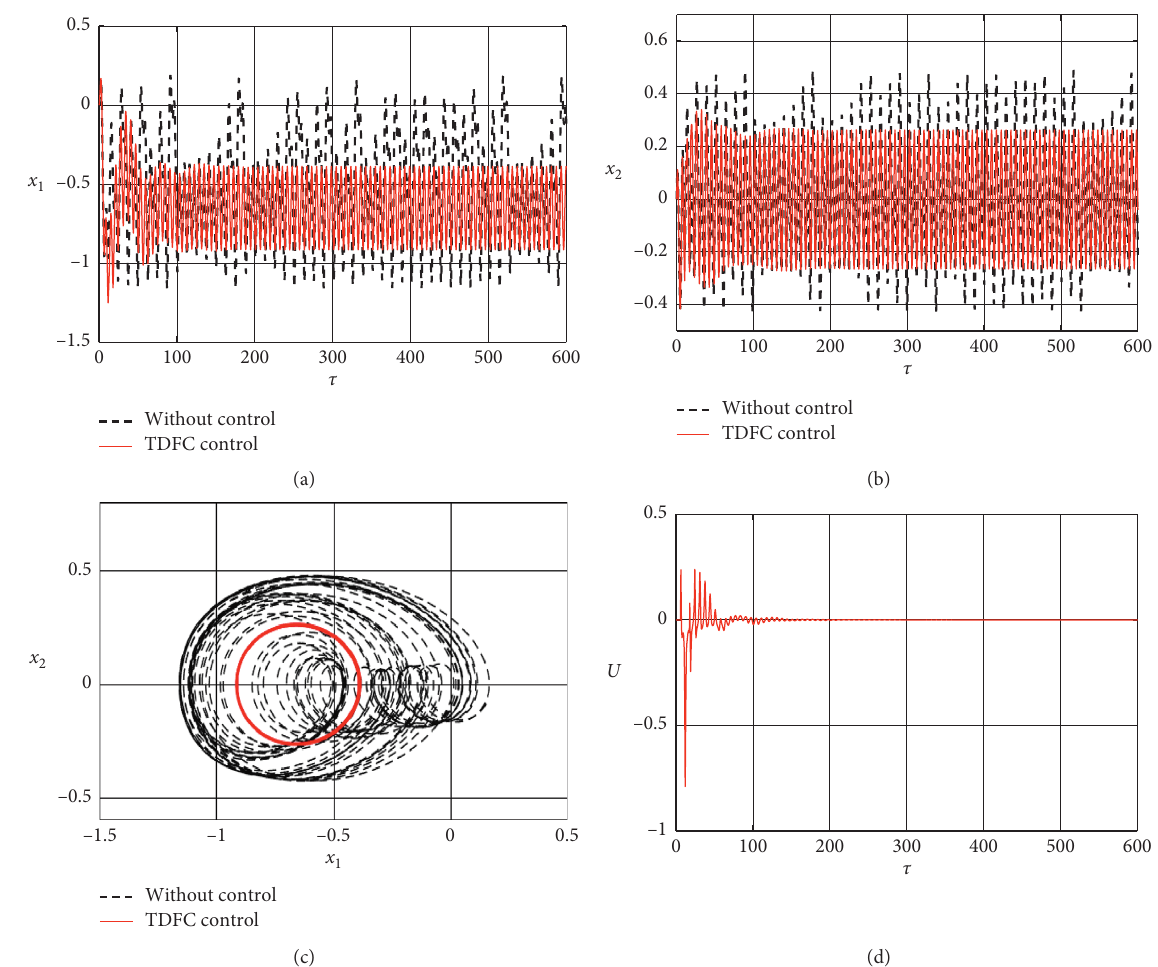
Figure 7: Time histories of (a) displacement and (b) velocity; (c) phase portrait of the system with controlled trajectory (solid line) and the trajectory without control (dashed line); (d) control signal U